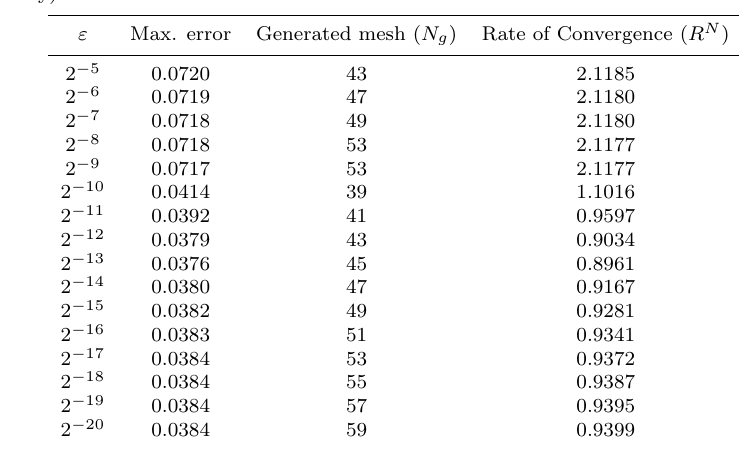
Maximum absolute error for Example 3 for different values of ε with N = 23 (initially) ε Max. error Generated mesh ( N g ) Rate of Convergence ( R N ) 2 −